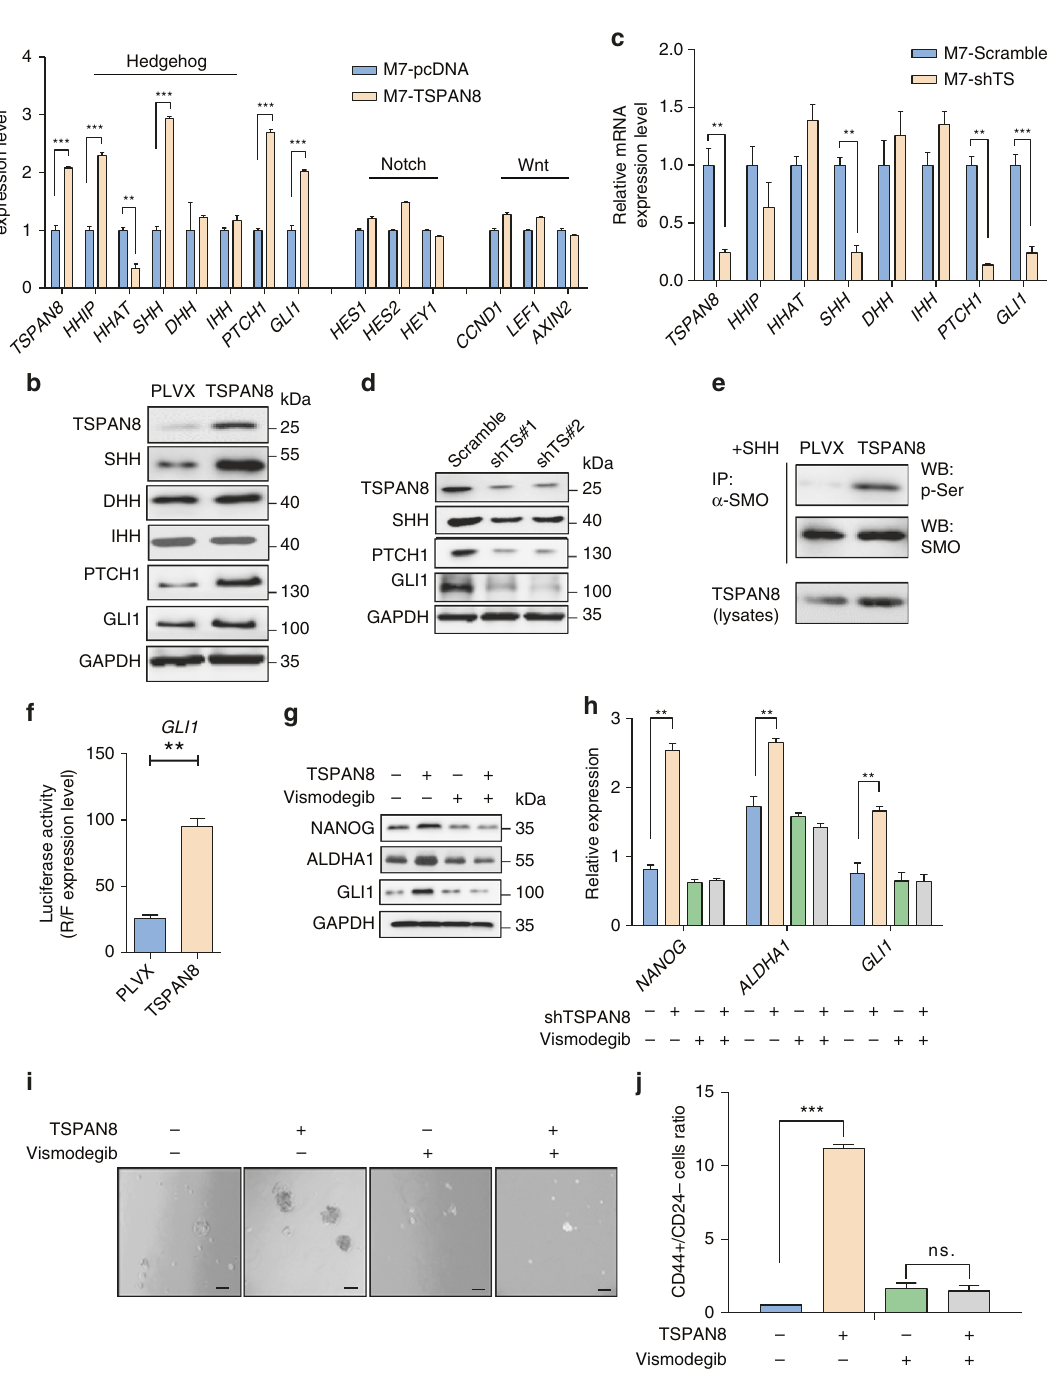
+ns. Fig. 3 TSPAN8 promotes cells stemness by activating Sonic Hh. a qRT-PCR analyses of the mRNA levels of the indicated genes in MCF7 cells with or without TSPAN8 overexpression ( n = 3). b Immunoblotting analyses of MCF7 cells with or without TSPAN8 overexpression were performed with the antibodies indicated. GAPDH was used as loading sample control. c qRT-PCR analyses of the mRNA levels of the genes indicated in MCF7 cells with or without TSPAN8 depletion ( n = 3). Data represent the mean ± SD of three times of independent experiments. *** P < 0.001. d Immunoblotting analyses of MCF7 cells with or without TSPAN8 depletion were performed with the antibodies indicated. GAPDH was used as loading sample control. e MCF7 cells with or without TSPAN8 overexpression were treated with SHH (100 ng/ml) for 6 h. Immunoblotting analyses and immunoprecipitation were performed with the antibodies indicated. P-Ser, phosphorylated serine. f Luciferase activities in MCF7 cells infected with lentivirus expressing TSPAN8 and GLI1 promoter – luciferase reporter construct were determined. GLI1 promoter reporter activity was normalized by comparison with Renilla luciferase activity ( n = 3 per group). Two-tailed unpaired Student ’ s t test was performed. ** P < 0.01. g – j MCF7 cells with or without TSPAN8 overexpression were treated with or without 10 nM Vismodegib for 6 h and immunoblotting analyses were performed ( g ). qRT-PCR analyses of the mRNA levels were conducted. Data represent the mean ± SD of three times of independent experiments. ** P < 0.01 ( h ). Representative images of tumor spheres are shown. Spheres were cultured for a week before counting. Scale bar = 50 µ m ( i ). Flow cytometry analyses of the ratios of CD44 + /CD24 − in these cells were performed ( j